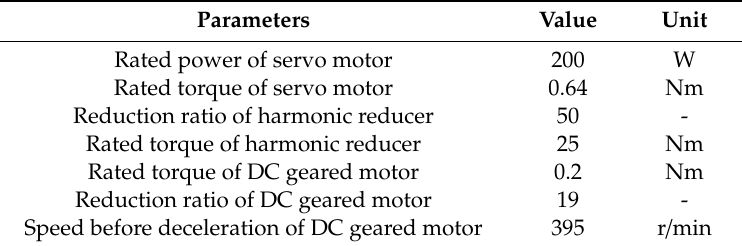
Table 1. Parameters of motor and reducer.